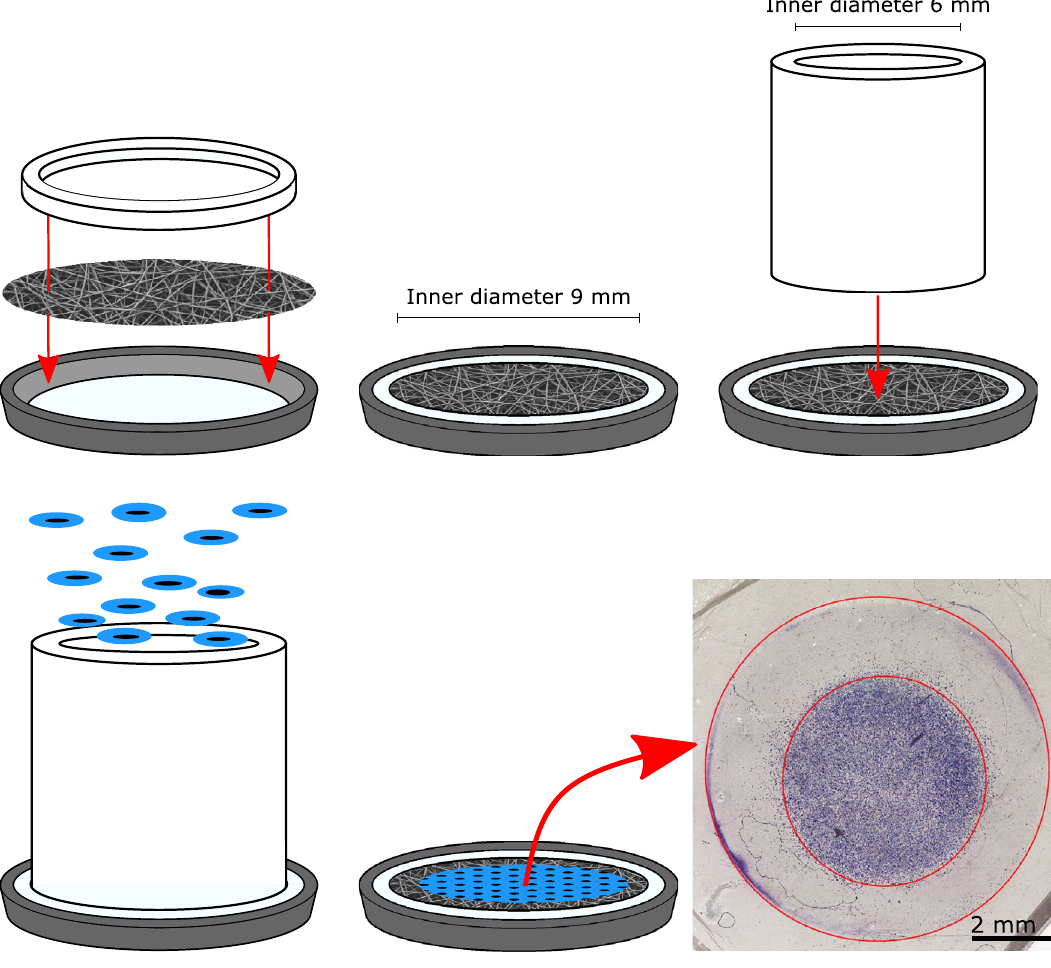
Figure 3. Fixation of the scaffold in the tissue carrier. The nanofibrous scaffold is fixed between the two rings. For the initial cell seeding, a sterile hollow cylinder is placed on the scaffold to enhance a precise cell attachment. HE staining of HCECs can be seen at the bottom right, displaying the cell seeding pattern resulting in a homogenous ECD within the inner red circle. The outer red circle indicates the circumference of the exposed sample.